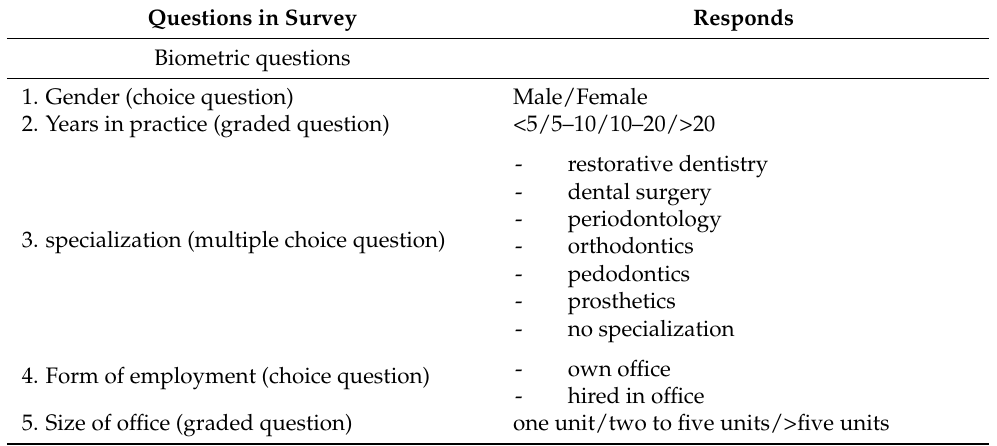
Table 1. Questions included in the